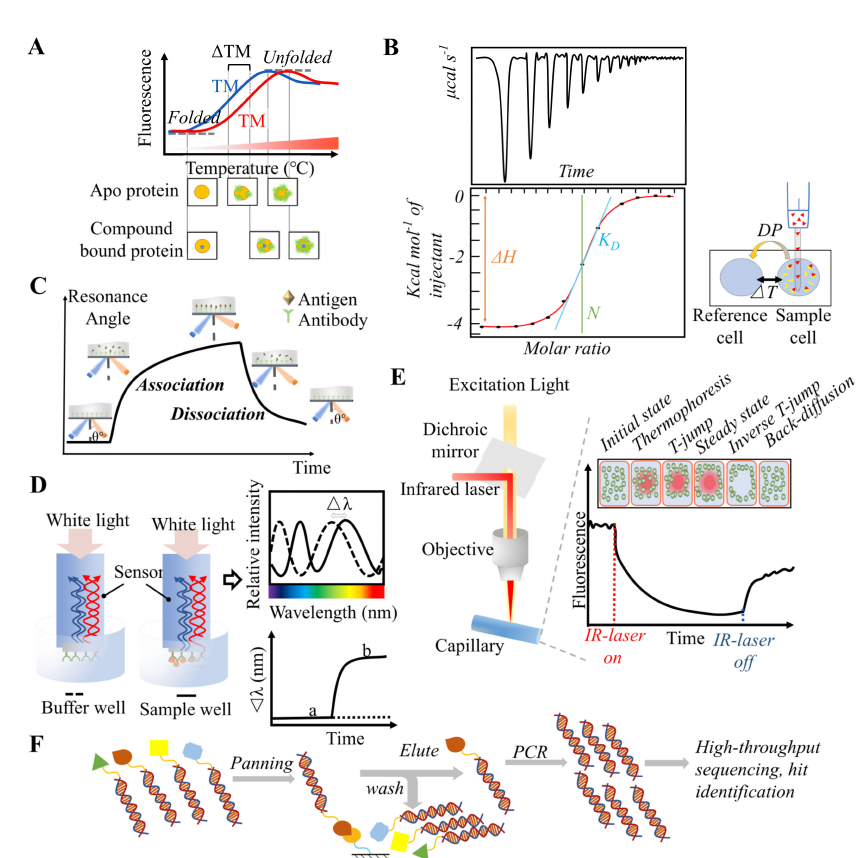
Figure 4. Illustration of affinity − based methods. ( A ) Thermal shift assay (TSA). ( B ) Isothermal Titration Calorimetry (ITC). ITC instruments are composed of a sample cell and a reference cell, both of which are coated by an adiabatic jacket. The temperature difference between the two cells is detected by a connected sensitive thermocouple circuit during the titration process. ( C ) Surface plasmon resonance (SPR). The protein is first immobilized onto the sensor chip by covalent coupling or interaction with specific fusion tag-containing antibodies. Then, the ligand solution flows across the chip surface in the microfluidic channel and continuously binds to the protein. This results in a change in the refractive index of the metal surface and an SPR angle shift. ( D ) Biolayer interferometry (BLI). The target protein is first immobilized onto the biosensor tip to form a bio-layer, and the biosensor is then dipped into a ligand-containing solution. When ligands bind to the immobilized protein, the thickness of bio-layer will increase. After white light passes through the bio-layer of the biosensor, the transmitted light and reflected light form light interference, which is visualized as an interference spectrum. The change in the thickness of the bio-layer induces a wavelength shift ( ∆ λ ). ( E ) Microscale thermophoresis (MST). In a standard MST experiment explored in a capillary, the target protein is labeled with a fluorescent protein or N-hydroxysuccinimide dye. Initially, the fluorescent molecules are distributed freely and uniformly. Then, a microscopic temperature gradient is induced by an infrared laser that causes the fluorescent proteins to move away from the heated area and reach an equilibrium state. As the thermophoresis progress, the fluorescence decreases. After turning off the infrared laser, the fluorescent molecules return to a uniformly distributed state and the fluorescence returns to its initial level. ( F ) DNA-encoded library (DEL) technology. The target protein is first anchored onto a solid support, usually magnetic beads, and then, the target protein is incubated with the compound library. After thorough washing, the high-affinity ligands that remain bound the target protein and their corresponding structures are analyzed. The DNA barcodes are sequenced, decoded, and resynthesized, and the affinity binding assay is repeated to validate the